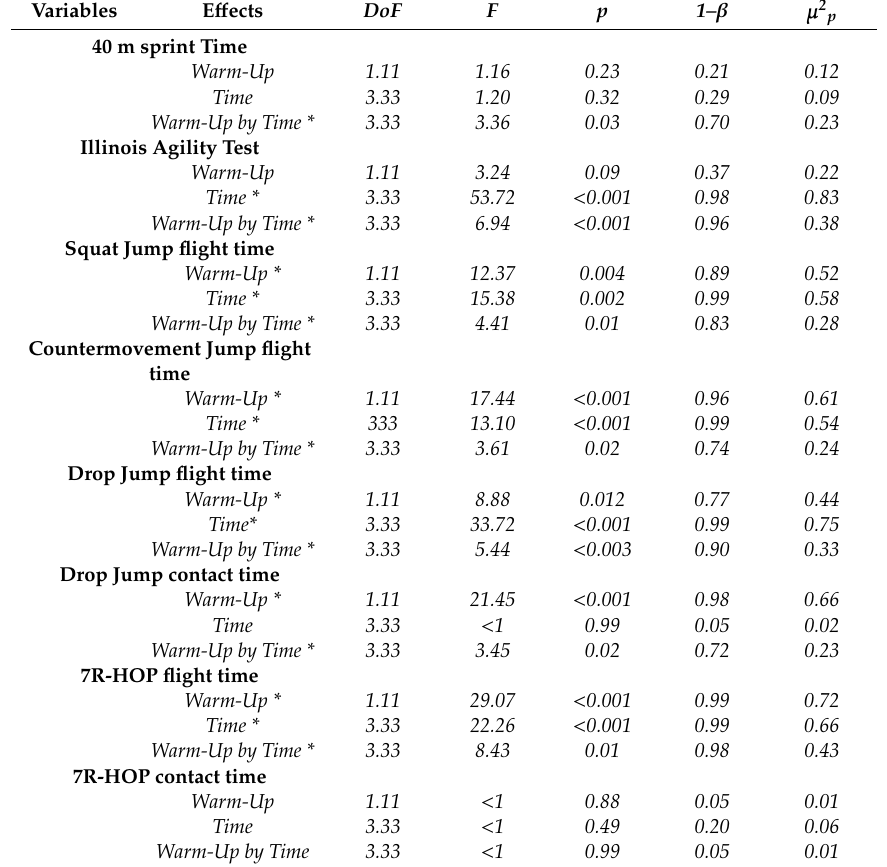
Table 1. Report of the full statistics for the main e ff ects of warm-up, time, and the warm-up by